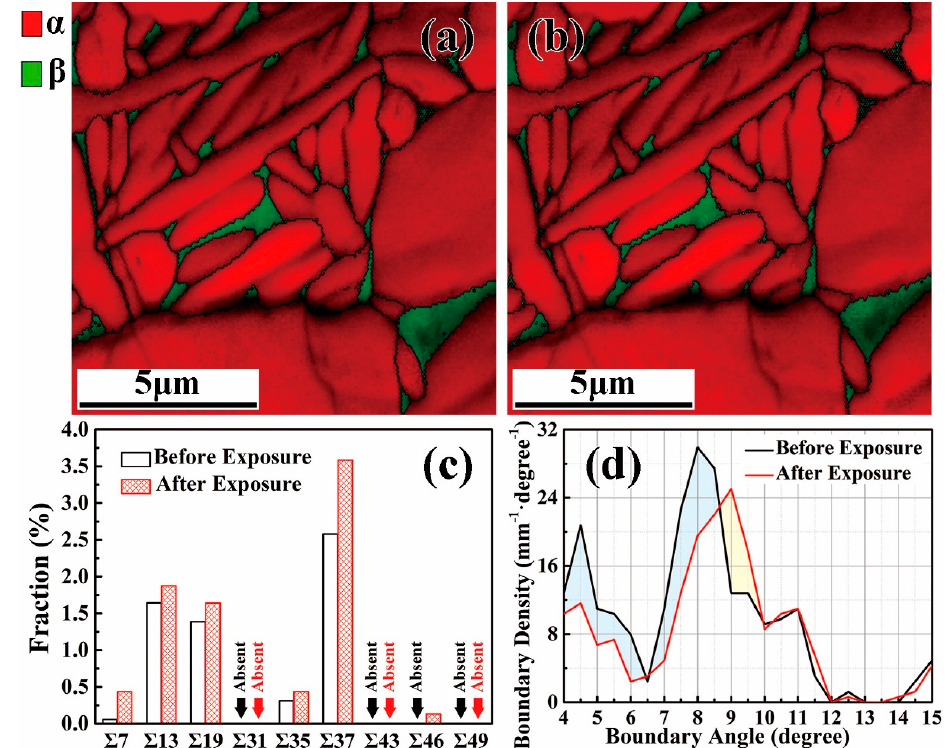
Figure 7. The maps of the phases and grain boundaries of the Ti-6Al-4V specimen ( a ) before and ( b ) after magnetic exposure; the statistical charts of ( c ) Coincidence Site Lattice (CSL) grain boundaries and ( d ) low-angle grain boundaries before and after magnetic exposure.